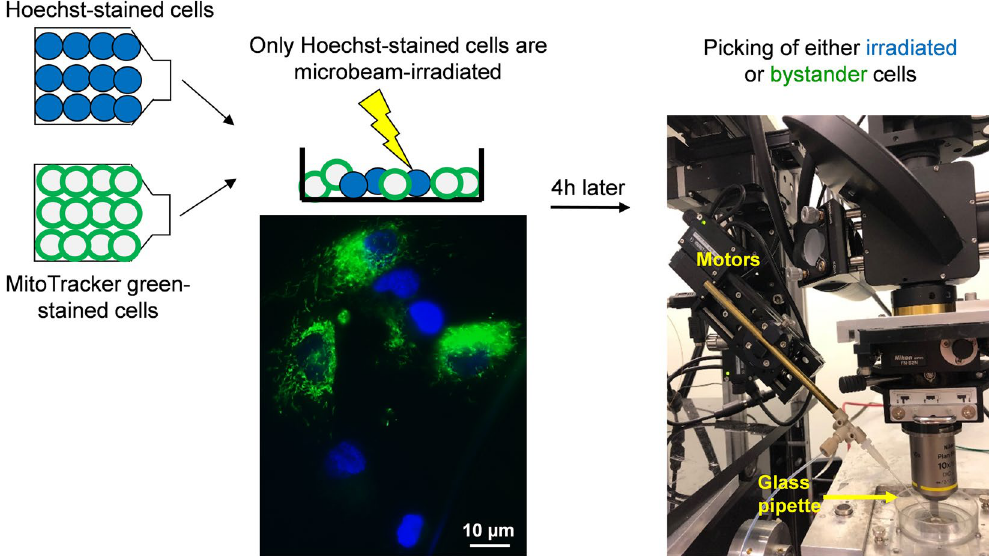
Figure 6. A co-culture of Hoechst-stained IMR-90 cells (blue) with MitoTracker green-stained IMR-90 cells (green) was established on microbeam dishes; at the endstation only Hoechst-stained cells were irradiated while the cytoplasmic-stained cells were designated as bystanders; single-cell picking was conducted 4 h after irradiation using a capillary micropipette with computer controlled positioning